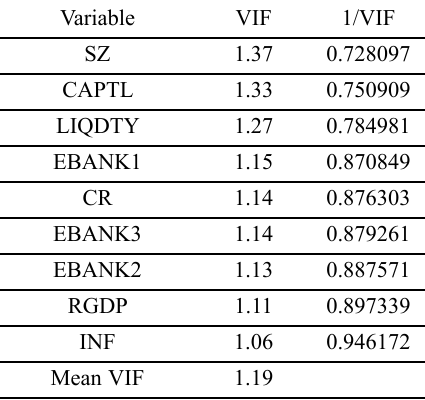
Table 3. Values of variance inflation factors’ Variable VIF